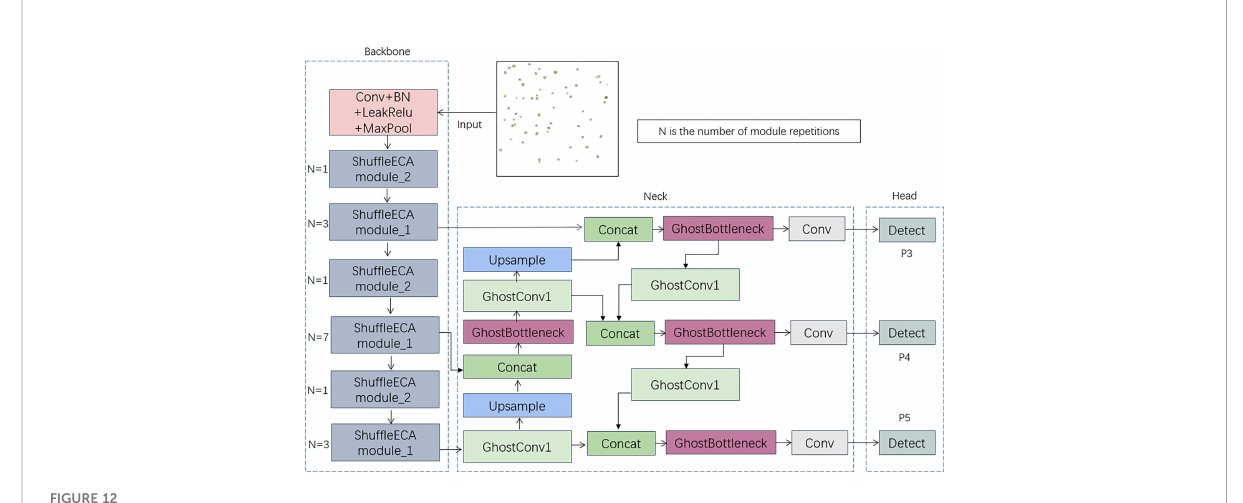
FIGURE 12 Algae-YOLO overall network